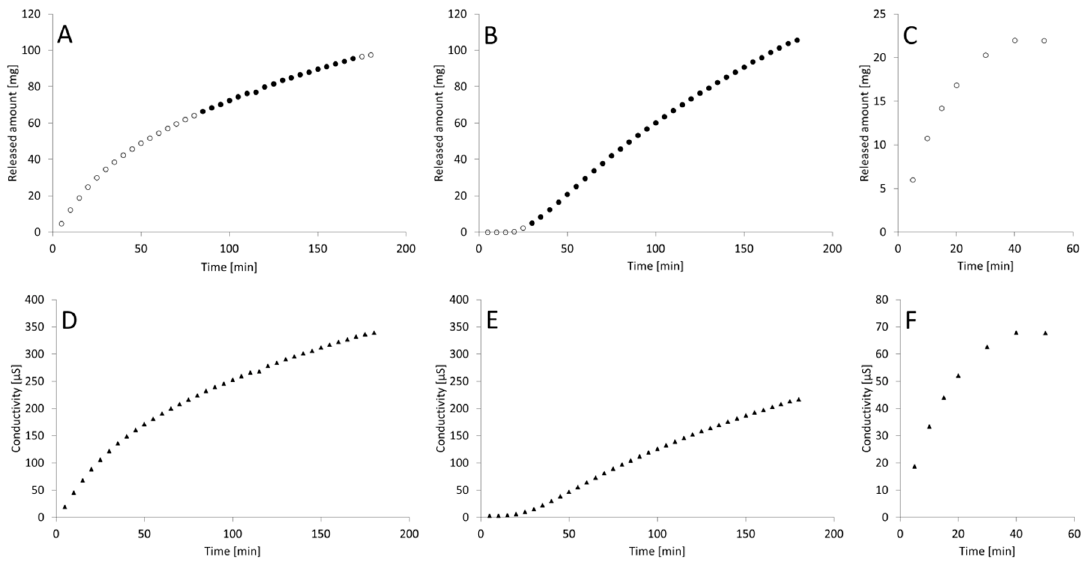
Figure 1. The process of API release from tested preparations containing ferric ions, determined by the conductometric method. A–C: release profiles of preparations FEP1 (A), FEP2 (B), FEN3 (C), ○ — experimental data; ● —experimental data applied for the evaluation of approximated zero-order kinetics. D–C: raw conductivity results ( ▲ ) for FEP1 (D), FEP2 (E), FEN3 (F).